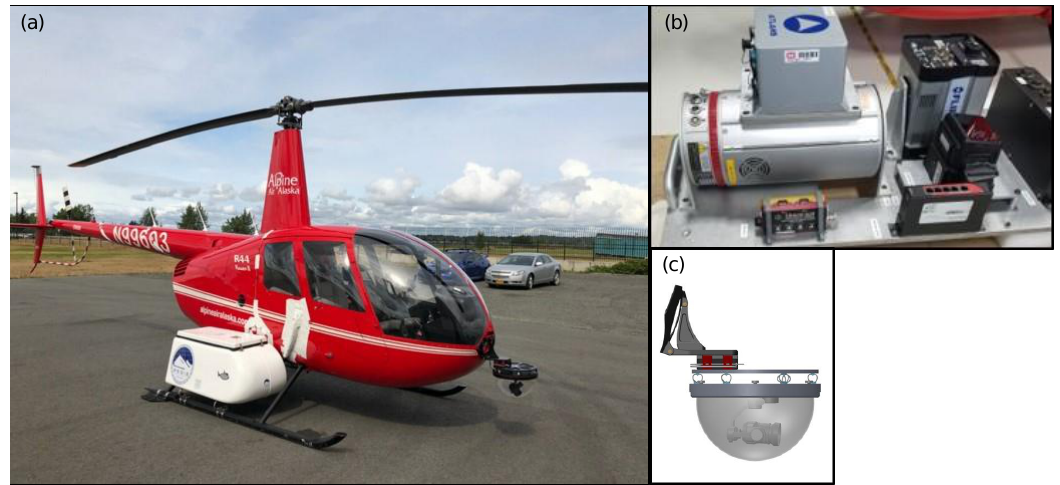
Figure 2. ( a ) The Robinson R44 helicopter used as a platform to acquire hovering image sequences. ( b ) Instrumentation housed within the pod mounted on the helicopter’s landing gear. ( c ) Schematic of the mount used to attach the video camera to the nose of the helicopter. Photo in ( a ) and schematic in ( c ) courtesy of Dominic Filiano and Adam LeWinter, respectively, of the U.S. Army Corps of Engineers Cold Regions Research and Engineering Laboratory. Table 2. Characteristics of the sensors used to collect data from the Salcha and Tanana